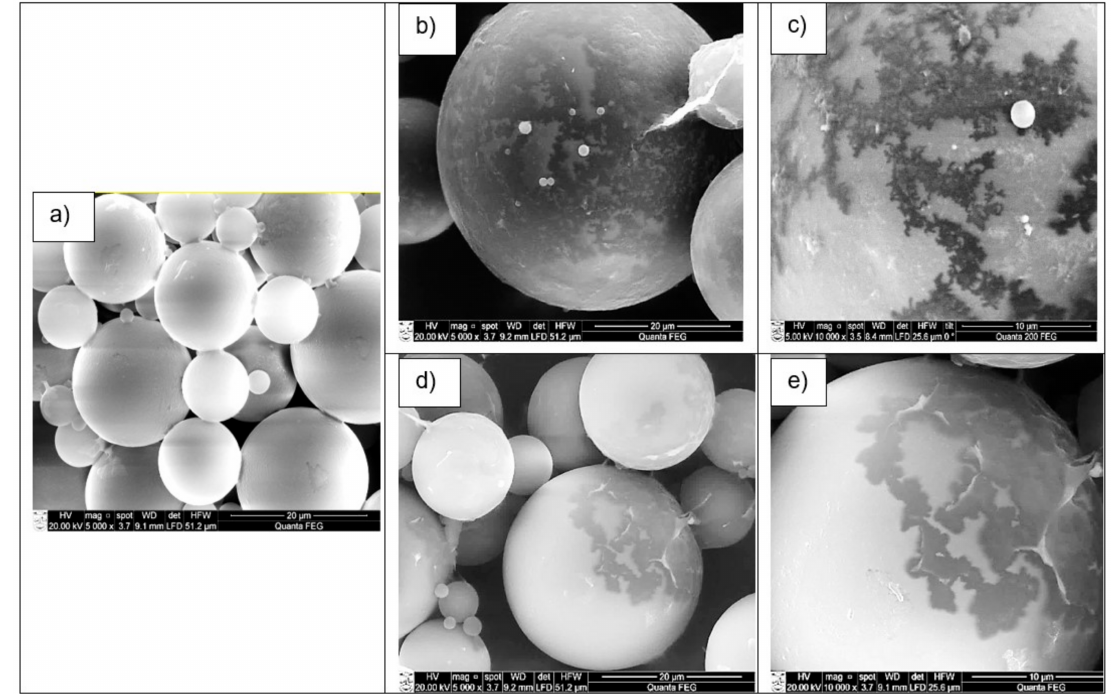
Figure 4. SEM micrograms of microcapsules MPCM32D: ( a ) unmodified, magnification 5000 × ; ( b ) with 5 wt.% MWCNTs shell-modified, magnification 5000 × ; ( c ) with 5 wt.% MWCNTs shell-modified, magnification 10,000 × ; ( d ) with 5 wt.% PEDOT: PSS shell-modified, magnification 5000 × ; ( e ) with 5 wt.% PEDOT: PSS shell-modified, magnification 10,000 ×